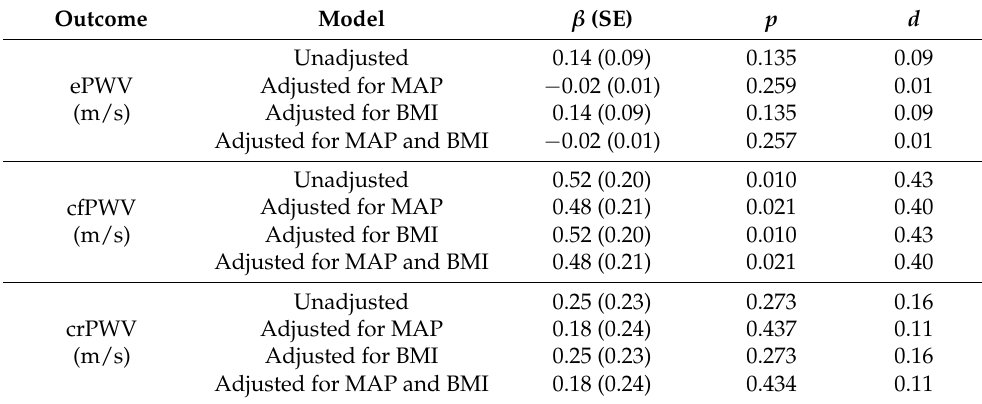
Table 3. Estimated (ePWV) carotid–femoral (cfPWV) and carotid–radial (crPWV) pulse wave velocity (PWV) responses to a simulated workday with prolonged sitting ( n = 25). Outcome